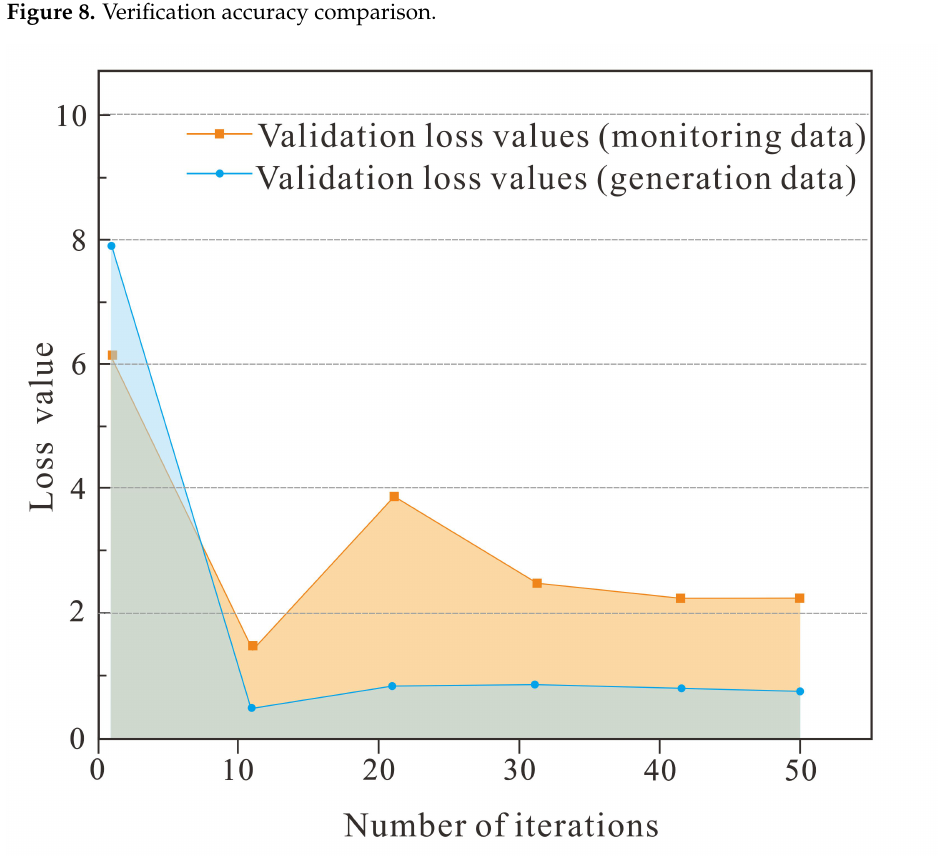
Figure 9. Verification loss value